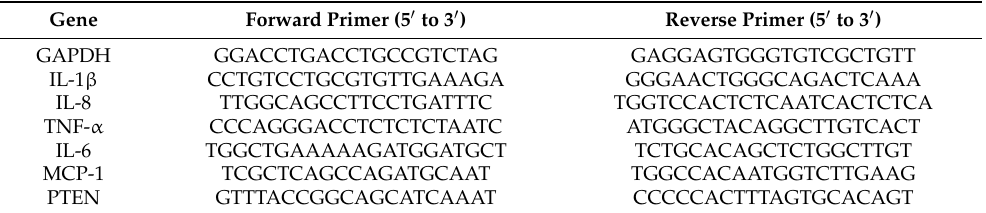
Table 2. The sequences of the primers used for the gene expression of membrane vesicle (MV)- induced genes in HaCaT cells. Gene Forward Primer (5 (cid:48) to 3 (cid:48) ) Reverse Primer (5 (cid:48) to 3 (cid:48) ) GAPDH GGACCTGACCTGCCGTCTAG GAGGAGTGGGTGTCGCTGTT IL-1 β